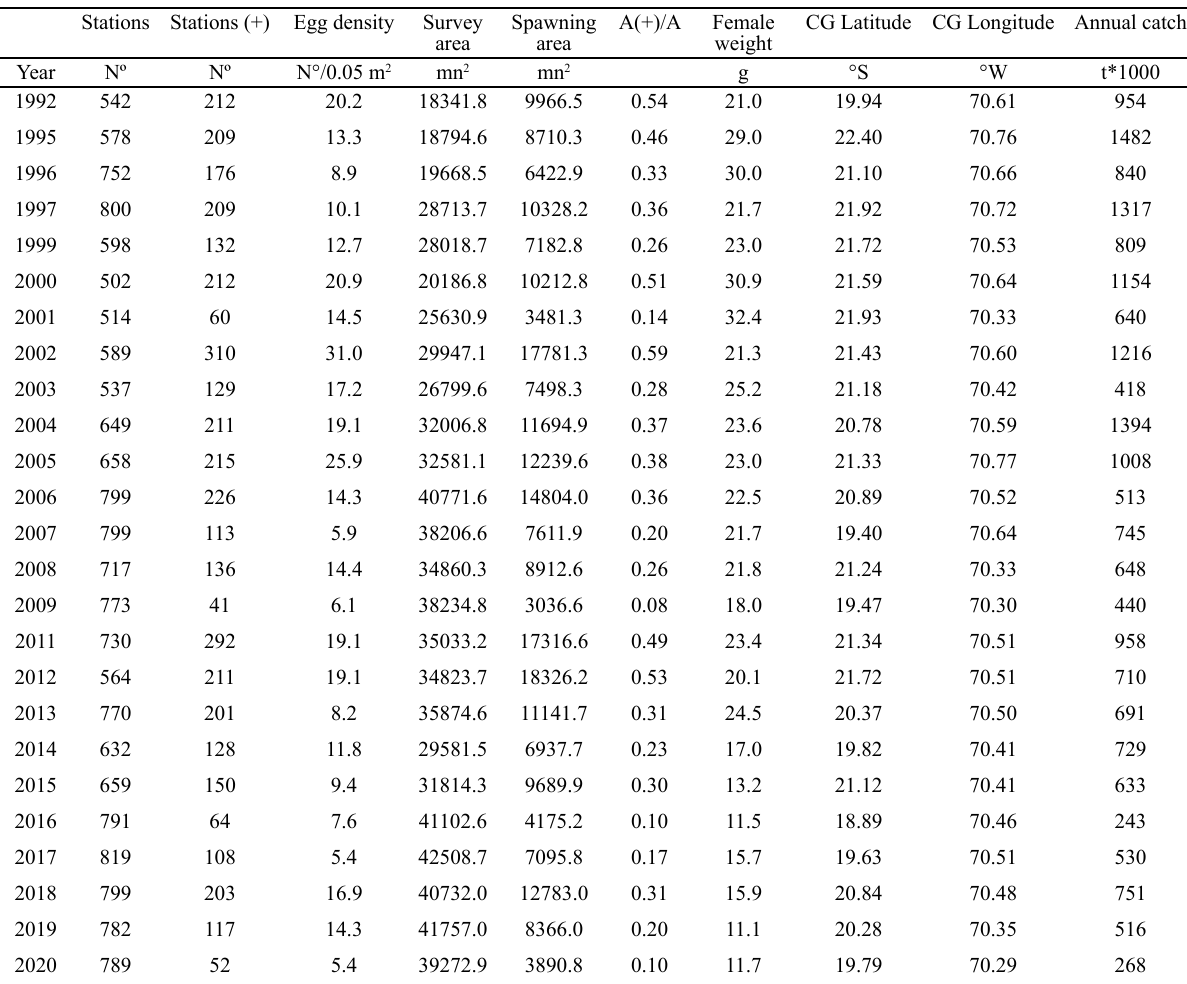
Table 1. – Information used in the study. Stations (+): number of stations with anchovy eggs. CG, centre of gravity in latitude (°S) and longitude (°W); A, survey area; A(+), spawning area; A(+)/A, spawning area/survey area. Stations Stations (+) Egg